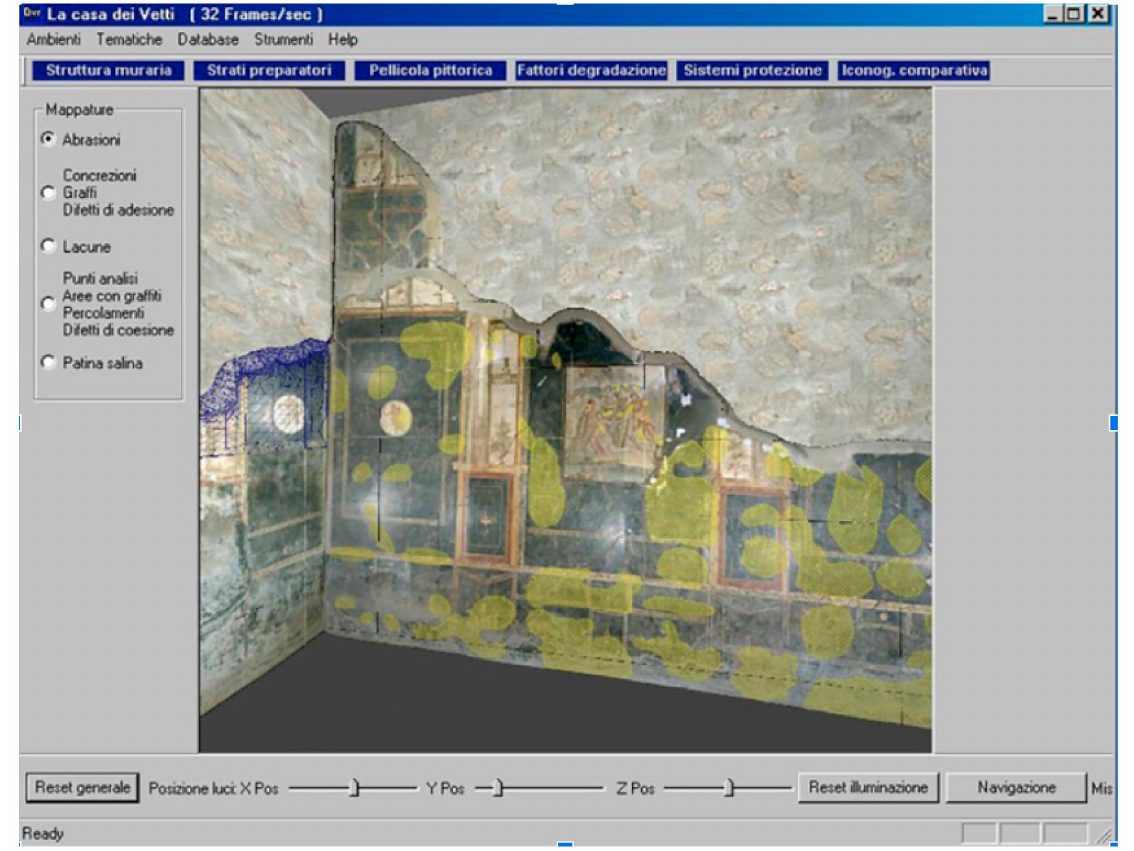
Figure 2. Vettii House, in Pompei. Desktop VR application aiming at documenting and interacting with the different levels of the diagnostic study. A pioneer case study realized in